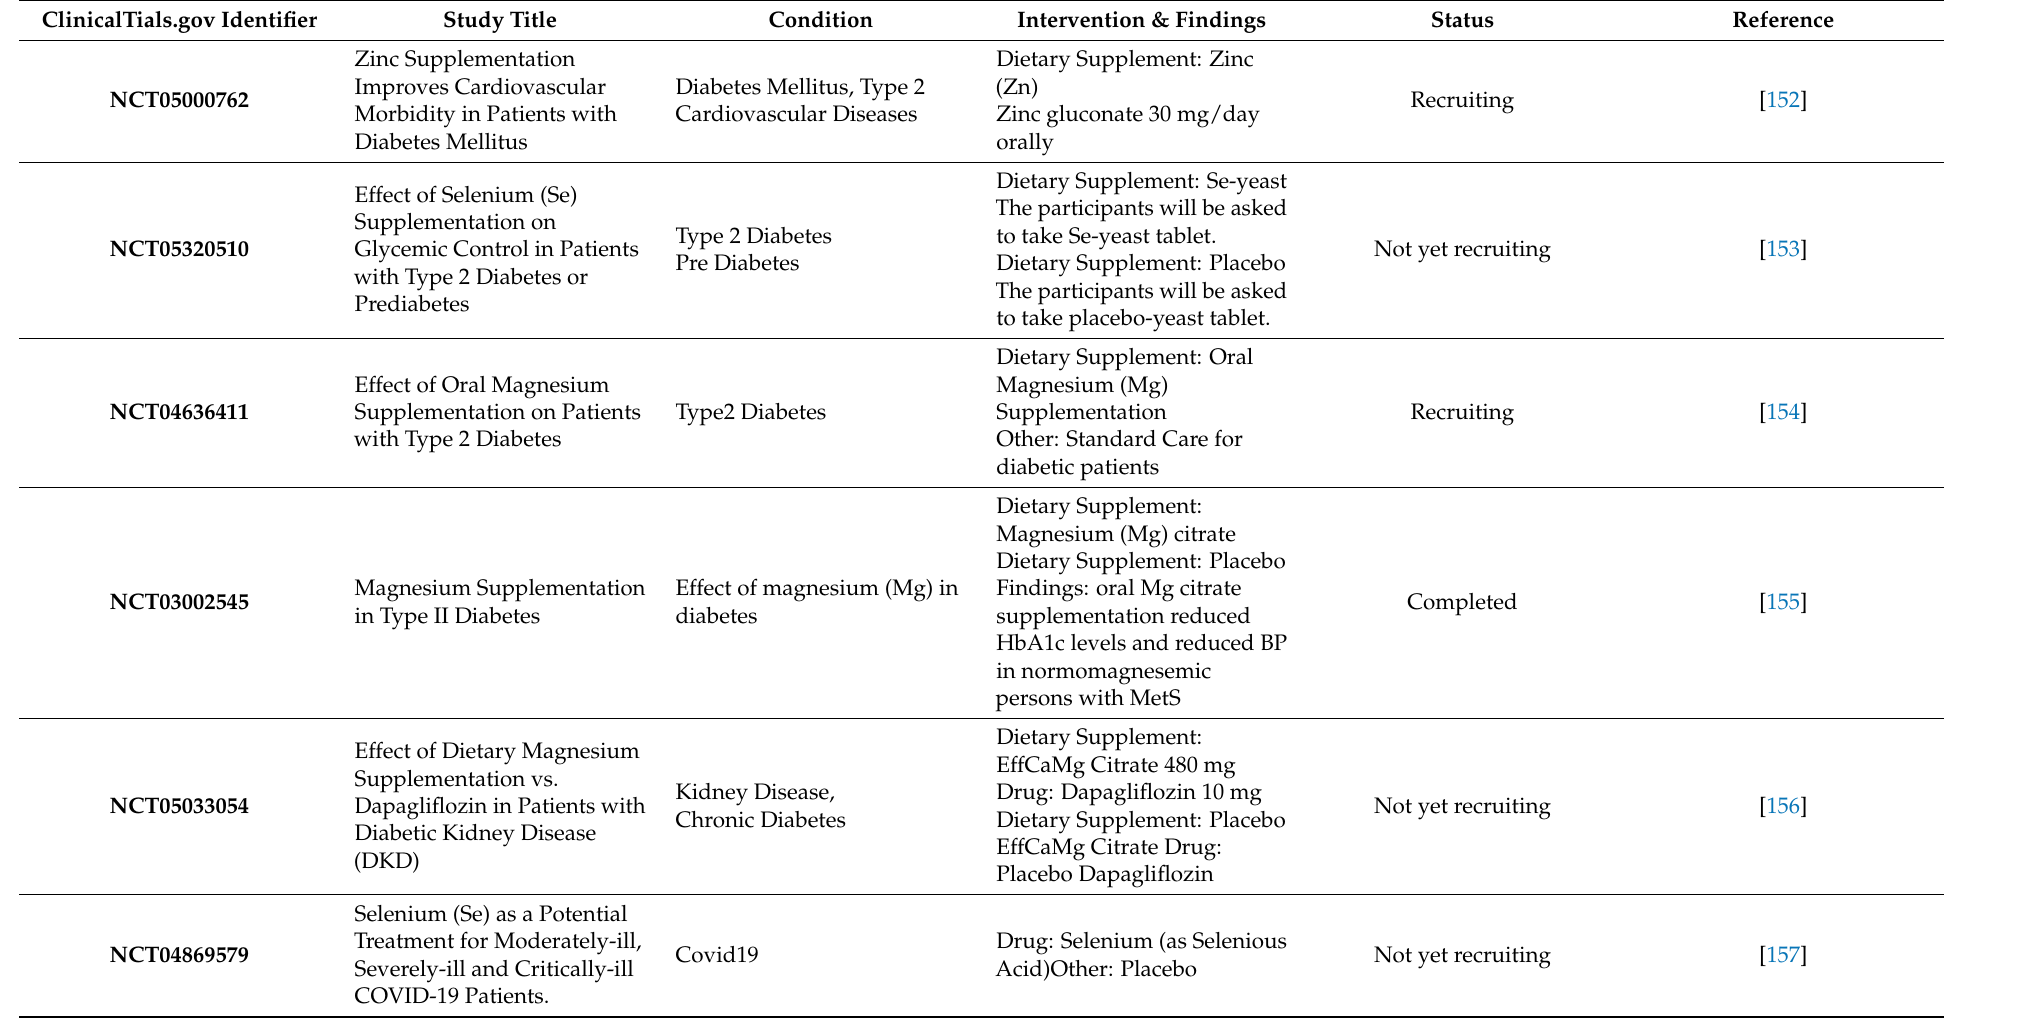
Table 2. Database of clinical trials on zinc (Zn), selenium (Se), copper (Cu), magnesium (Mg) and iron (Fe) interventions against hepatitis, covid19 and type-2 diabetes